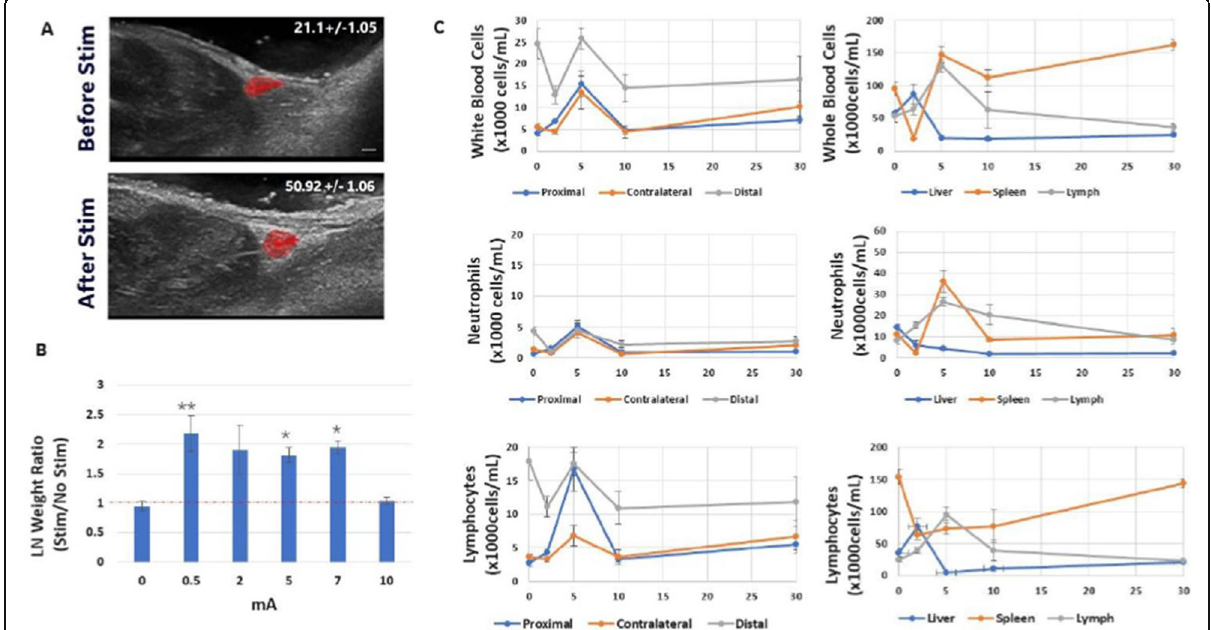
Fig. 3 a An ultrasound image of the same popliteal lymph node (LN) before and after electrical stimulation of the sciatic nerve directly above the LN site. The lymph node has been highlighted and the diameter of the lymph node before and after stimulation is shown. b The total weight of excised lymph nodes without (0 mA; sham control) or with electrical stimulation at different stimulation intensities (0.5, 2, 5, 7.5, 10 mA; using stimulation frequency of 20 Hz with 50 msec pulse length). c (left panels) The concentration of white blood cells (WBC), neutrophils (NE), or lymphocytes (LY) taken from the stimulated (direct LN) and other distal lymph nodes (contralateral popliteal and axillary LN) at different times after electrical stimulation of the sciatic nerve above a popliteal lymph node (0, 2, 5, 10, and 30 min following stimulation). (right panels) The concentration of white blood cells (WMC), neutrophils (NE), and lymphocytes (LY) taken from the distal liver, spleen, and lymphatic fluid/ lymphatic duct sites at different times after electrical stimulation of the sciatic nerve above a popliteal lymph node (0, 2, 5, 10, and 30 min following stimulation). N = 9. One way ANOVA with multiple comparison analysis * = p ≤ 0.05, ** = p ≤ 0.005,*** = p ≤ 0.0005;